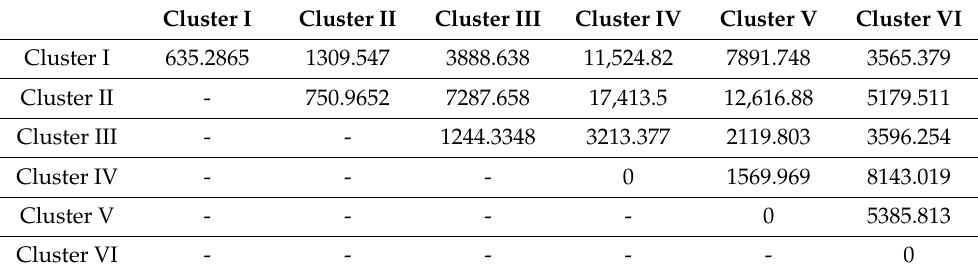
Table 4. Average inter (above diagonal) and intra (diagonal) cluster distances of six clusters computed from Mahalanobis’ D 2 analysis using 50 rice germplasm for 14 panicle- and yield-related traits. Cluster I Cluster II Cluster III Cluster